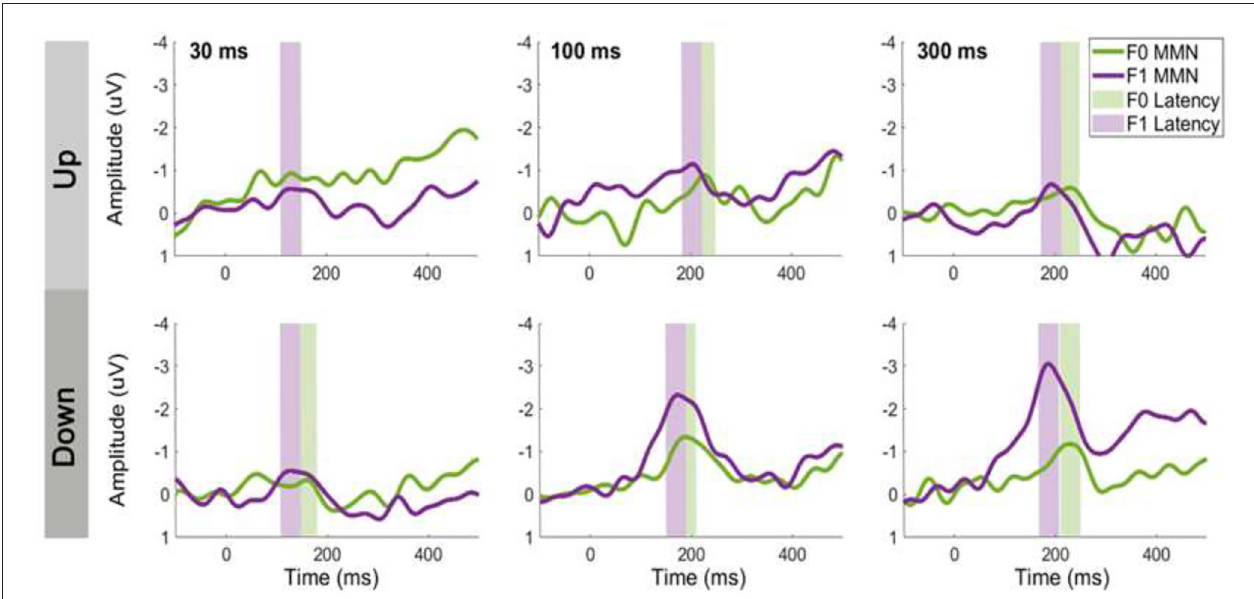
FIGURE 6 | The effect of formant frequency on MMN latency for upward (top panels) and downward (bottom panels) tone sweeps. Left to right panels show sweeps at three timescales (30, 100, and 300ms). Green and purple shaded region indicate peak latency ± 20-ms window. MMN waveforms are recorded at electrode Fz and computed based on same-stimulus